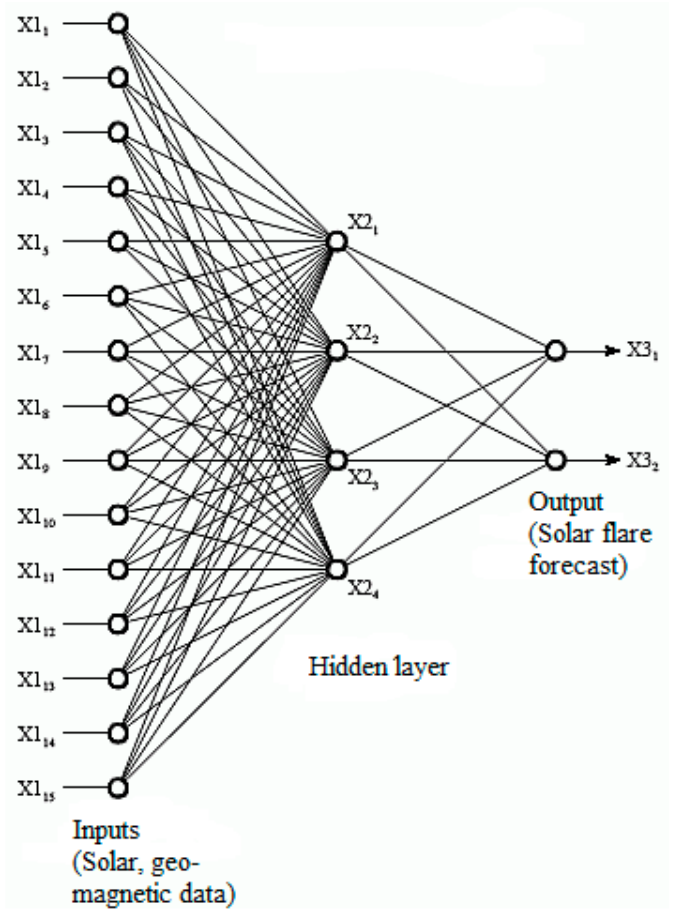
Figure 3. Structures of a traditional neural network for solar flare